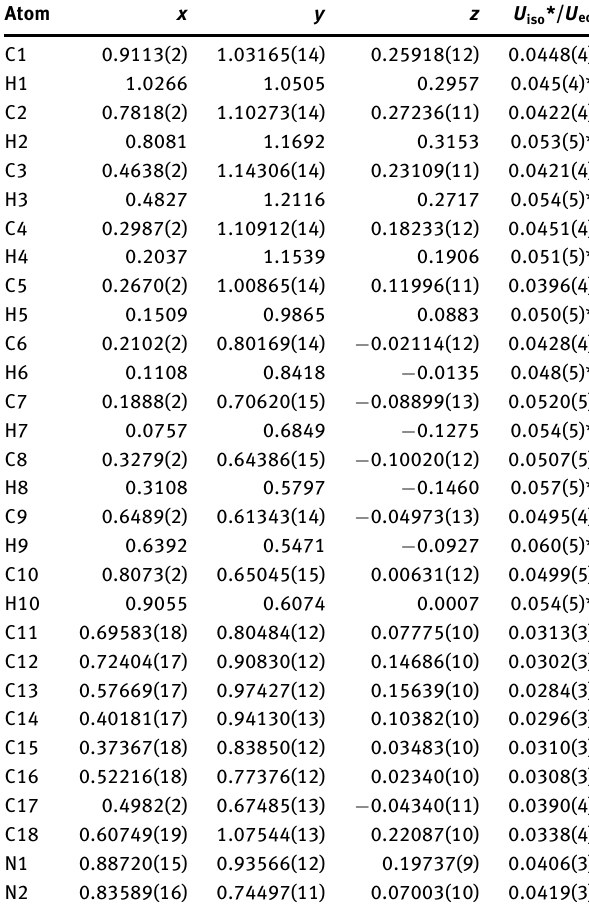
Table 2: Fractional atomic coordinates and isotropic or equivalent isotropic displacement parameters (Å 2